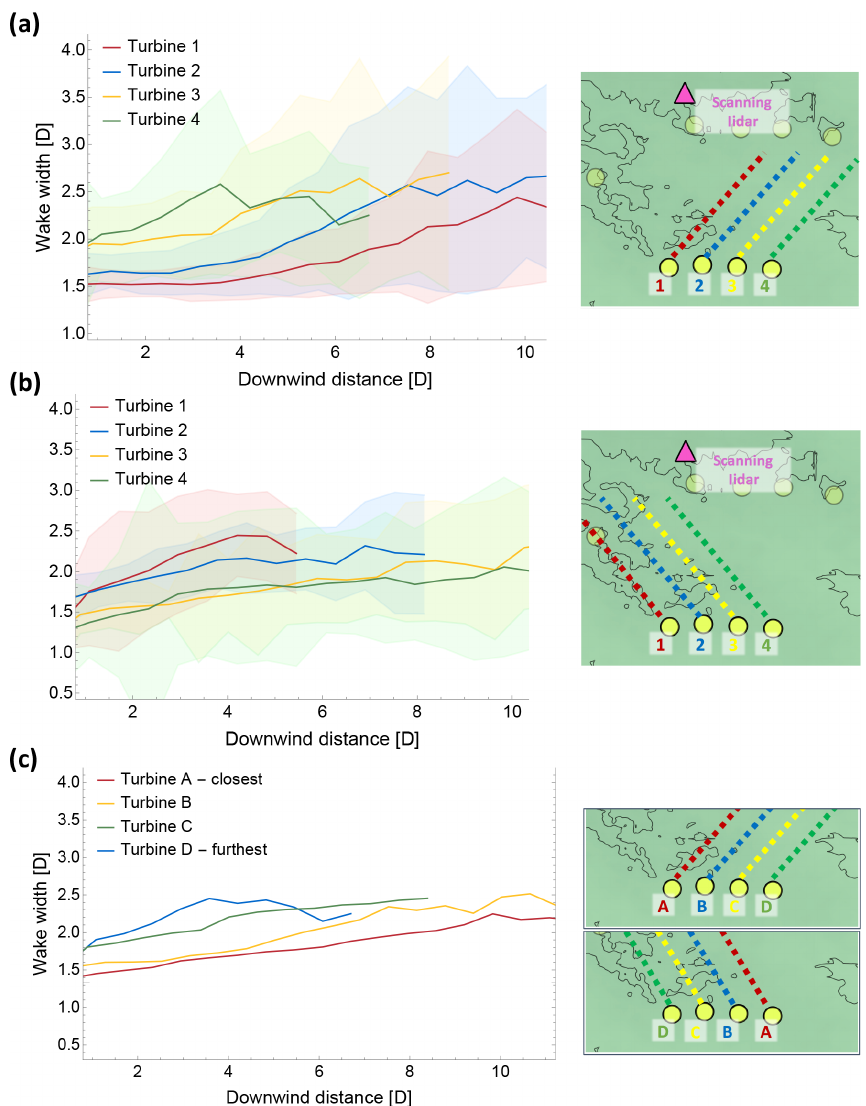
Figure 9. Wake width vs. downwind distance from the turbines, for the wakes of the four turbines in the studied row, from PPI scans performed at all the six considered elevation angles. Continuous lines represent median values; shaded areas show ± 1 standard deviation of the data. (a) Data from the night (stable conditions) of 26 August 2013, with southwesterly wind conditions. (b) Data from the night (stable conditions) of 23 August 2013, with southeasterly wind conditions. (c) Aggregated plot, average of data from the nights of 26 and 23 August, considering the single turbines with reference to their relative distance from the scanning